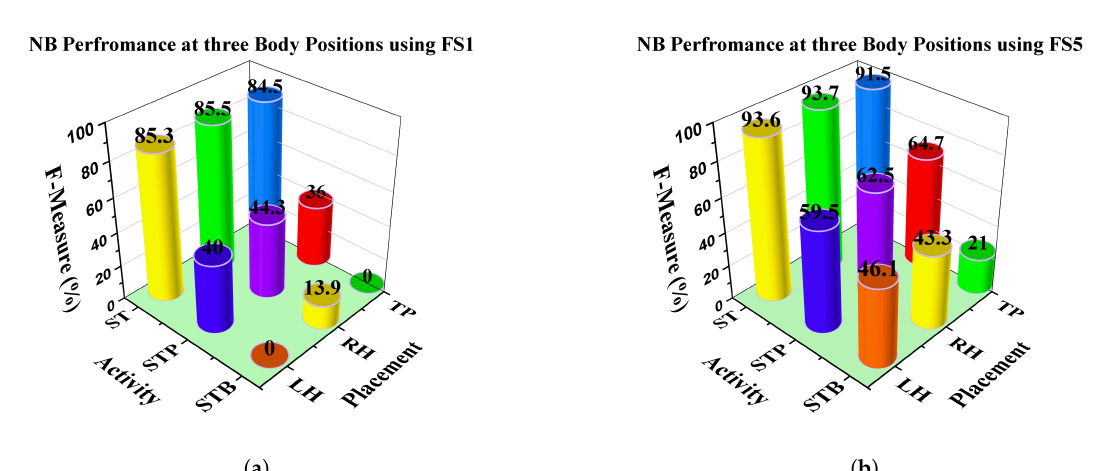
Figure A1. Recognition of activities at three body positions using